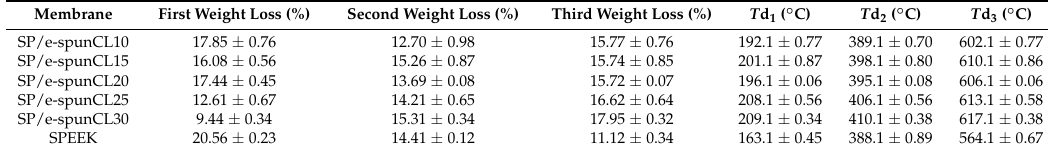
Table 2. Thermal degradation and char yield of the SP/e-spunCL and SPEEK membranes.